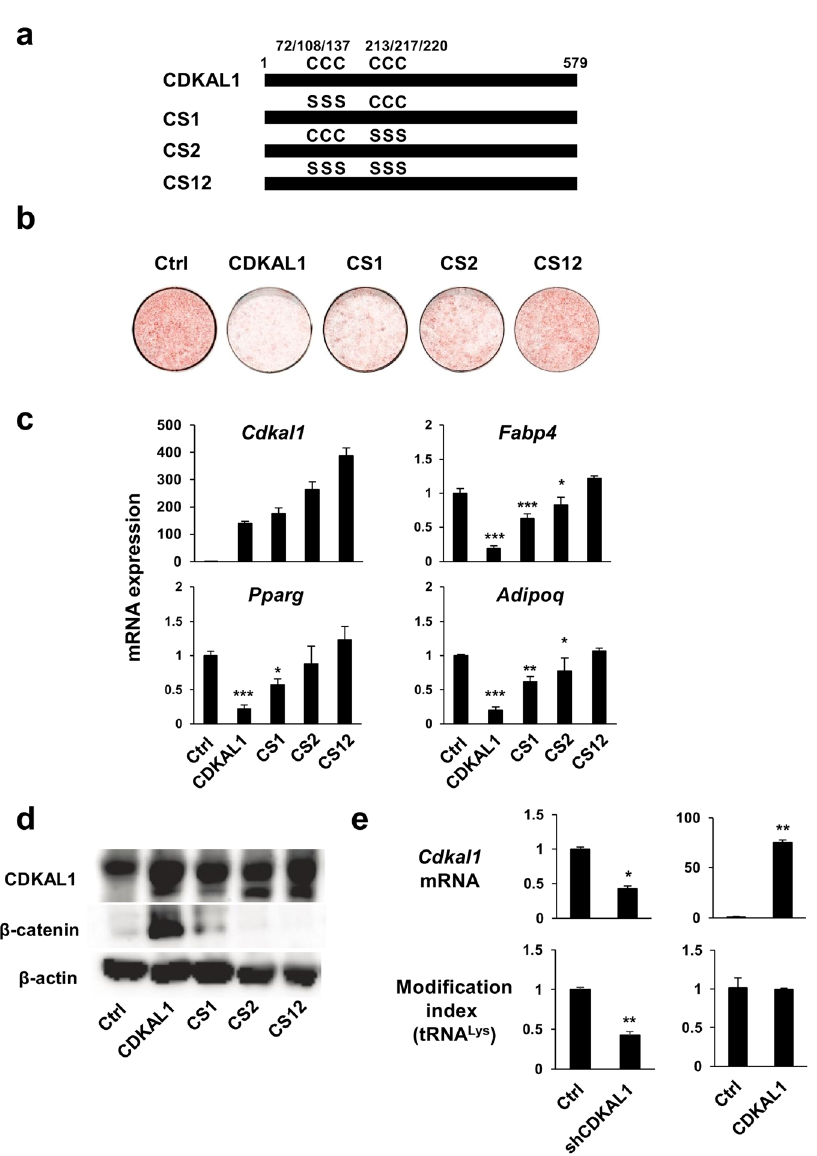
Figure 6. Conserved cysteine residues in the amino terminal region of CDKAL1 are essential for its anti- adipogenic action. ( a ) Diagram of constructs used in the experiment. The numbers indicate the amino acid residues from the N-terminus of CDKAL1. ( b ) Plate view of Oil Red O staining of differentiated 3T3-L1 cells expressing CDKAL1 with point mutations (Ctrl, control). ( c ) Gene expression levels in differentiated 3T3-L1 cells expressing CDKAL1 with the point mutations (n = 3, * p < 0.025, ** p < 0.005, *** p < 0.0005 vs control group by Dunnett’s test). ( d ) Western-blotting analysis of β -catenin protein in differentiated 3T3-L1 adipocytes expressing CDKAL1 with the point mutations. ( e ) Measurement of tRNA Lys (UUU) modification index in 3T3- L1 cells expressing shCDKAL1 ( * p < 0.05, ** p < 0.01 vs control group by Student’s t-test) and in 3T3-L1 cells expressing wild type CDKAL1 (n =